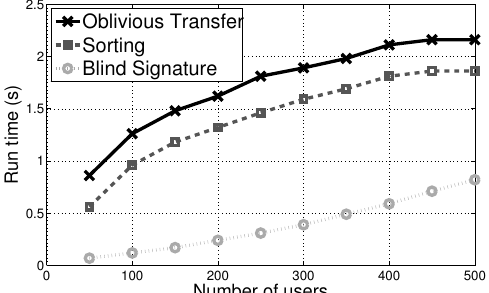
Figure 6. Run time of the sorting, the OT and the blind Signature of PVI-S with the users’ number when the budget’s value is